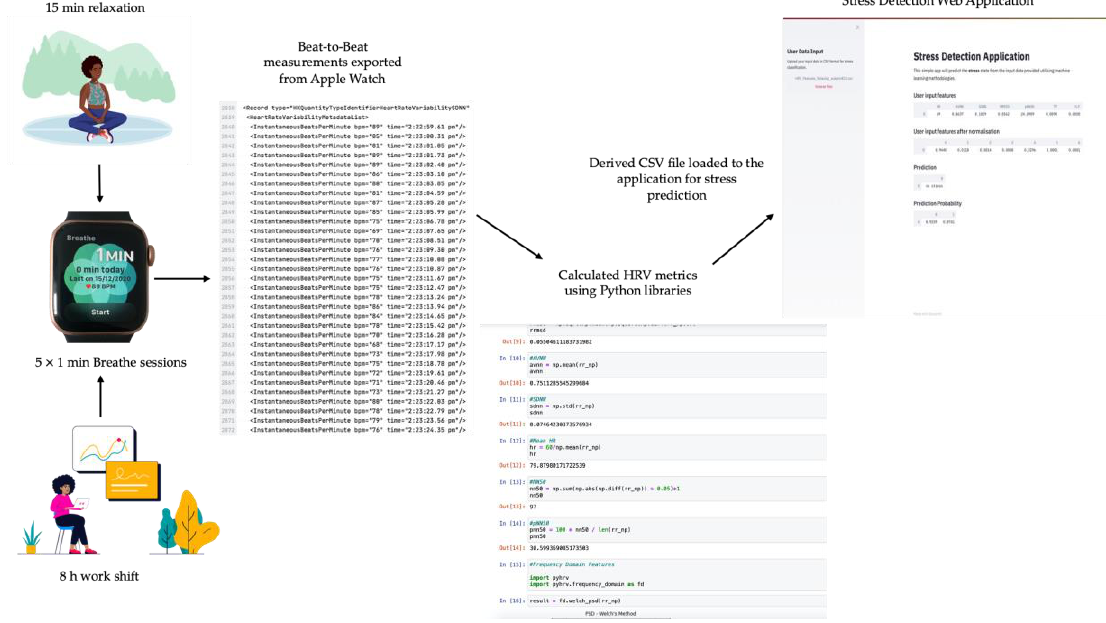
Figure 1. Illustration of the experimental procedure followed for stress detection on data obtained from Apple Watch